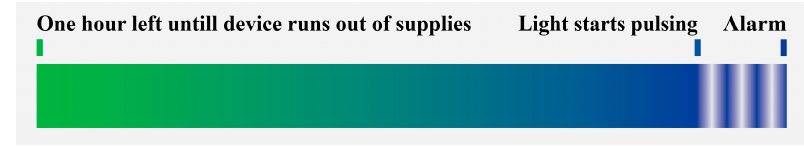
Figure 2. Transition of the CheckMates over time.